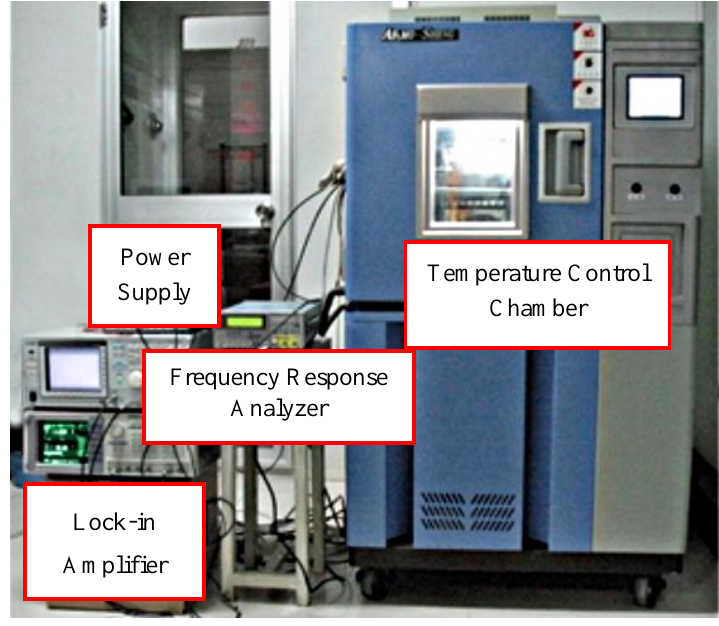
Figure 8. The temperature experimental setup of the